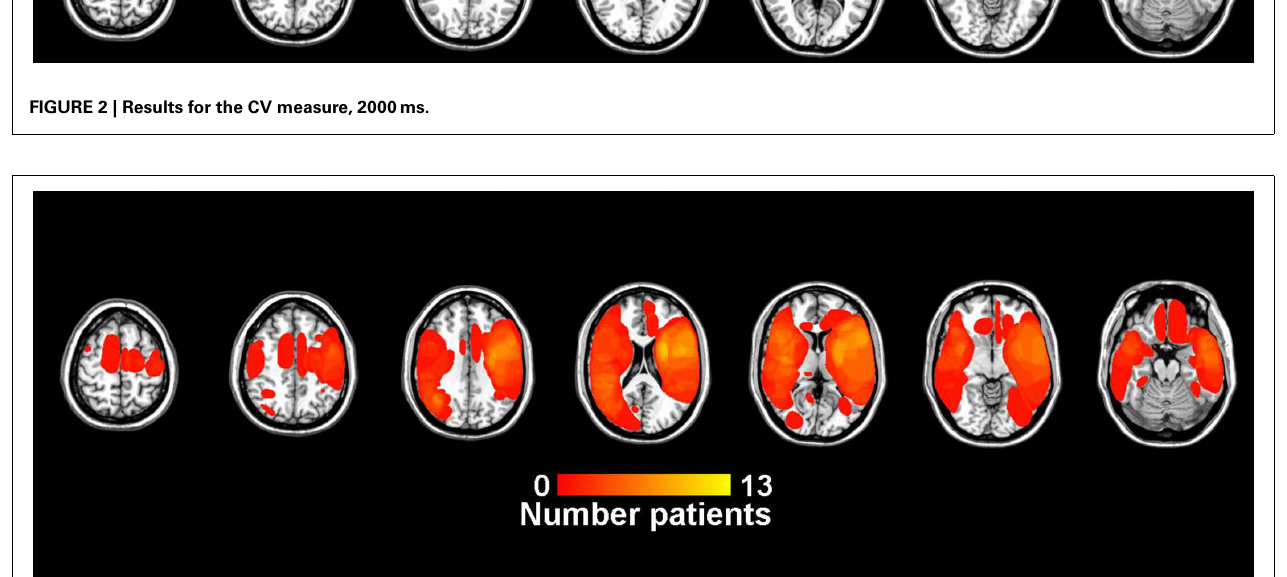
FIGURE 3 | Lesion overlap showing the number of patients with lesions at each voxel. InVLSM analyses, power to detect behavioral differences is due in part to differences in the number of patients with lesions at each voxel.